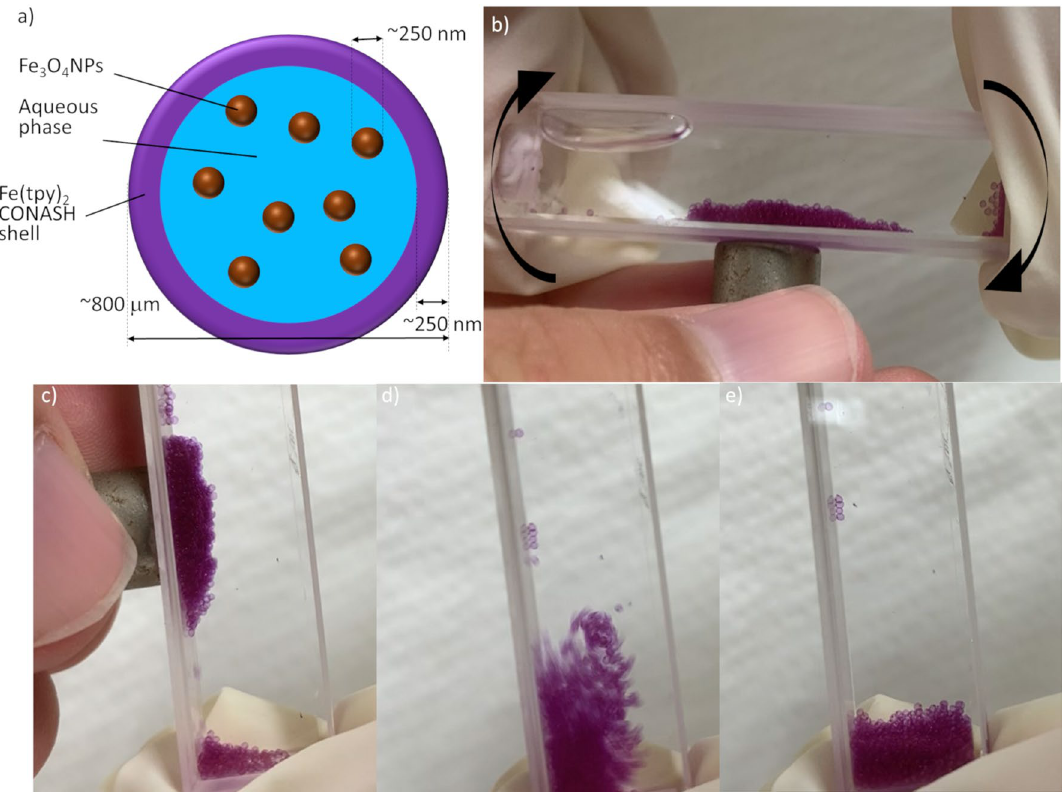
Figure 4. Magnetite-containing Fe(tpy) 2 CONASH capsules. ( a ) Schematic of magnetite-containing Fe(tpy) 2 CONASH capsules. ( b–e ) Snapshots of the magnetite-containing Fe(tpy) 2 CONASH capsules attracted by a